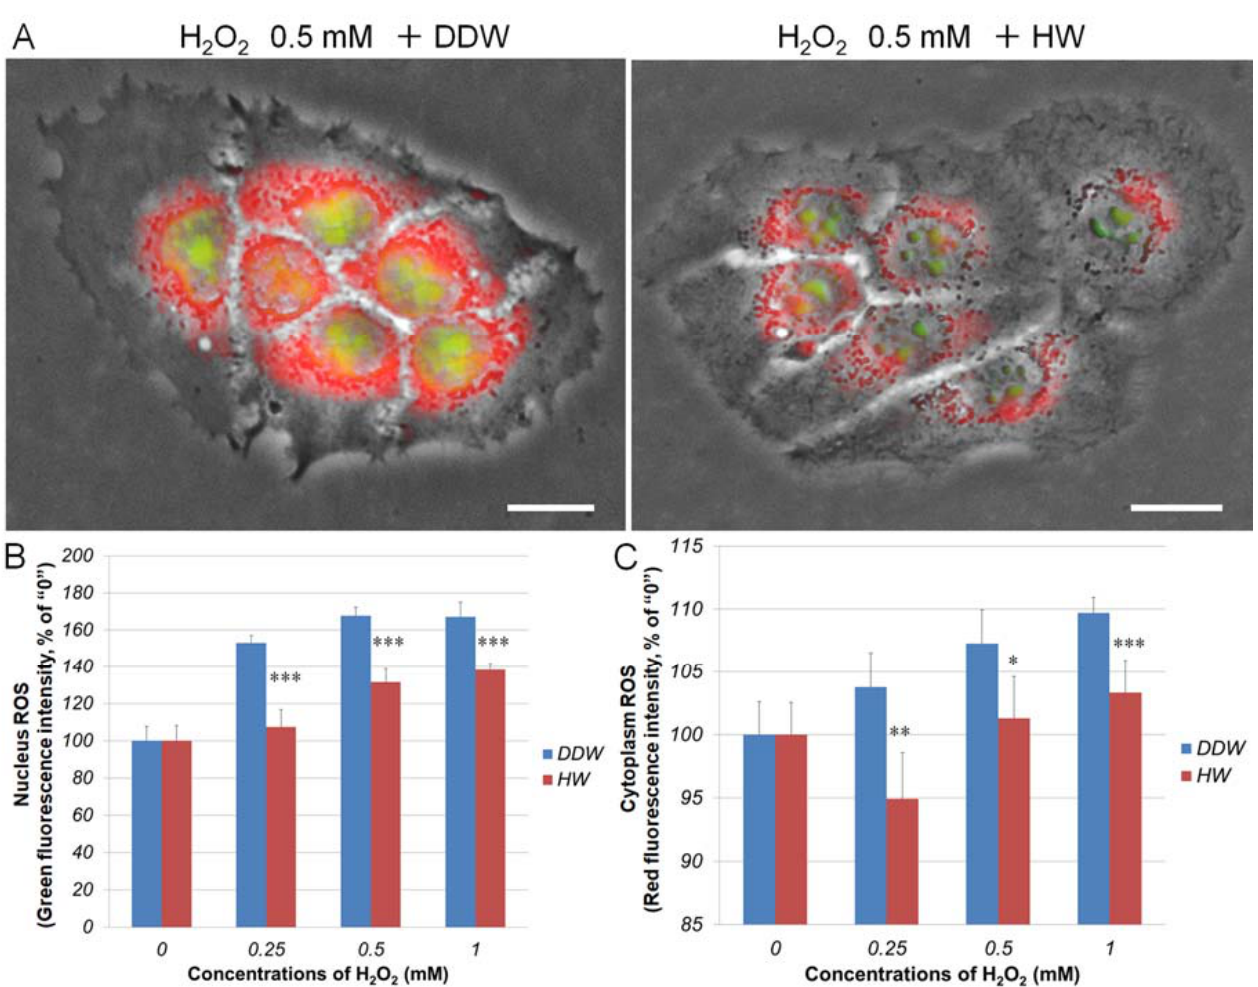
Figure 3. Repressive effects of HW on hydrogen peroxide-induced cellular ROS in human keratinocytes. HaCaT cells were pretreated with DDW- or HW-prepared medium for 2 h. Cells were then exposed with H 2 O 2 at different concentrations. At 24 h after H 2 O 2 -treatment, cellular ROS was detected with CellROX ® green and orange dyes and observed with a fluorescence microscope. To quantitatively analyze the cellular ROS, green and red fluorescence in HaCaT cells were measured with the Tali image-based cytometer. ( A ) Typical images of CellROX ® green and orange staining. Green, nucleus ROS; red, cytoplasm ROS. Scale bar = 10 µ m. ( B ) and ( C ) HaCaT cells were detached from the culture substratum-surface by trypsin and followed with Tali-cytometric analysis to determine nucleus and cytoplasm ROS as described in materials and methods. * p < 0.05; ** p < 0.01; *** p < 0.01 vs. 0 (without H 2 O 2 treatment). Each bar represents the mean ± SD of three independent experiments.